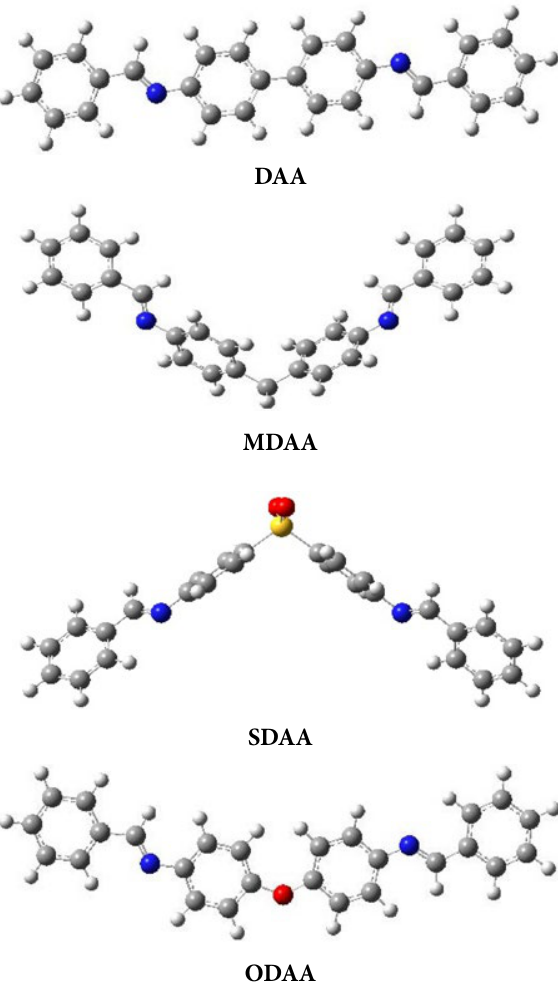
Figure 2: Optimized molecular structures of non-protonated inhib- itor molecules using B3LYP/6-31 G calculation level.